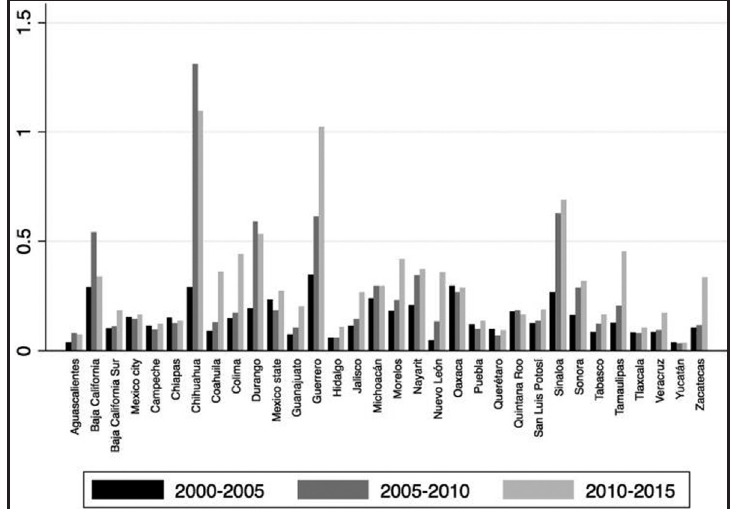
Homicide rate (per 1,000 people), by state and